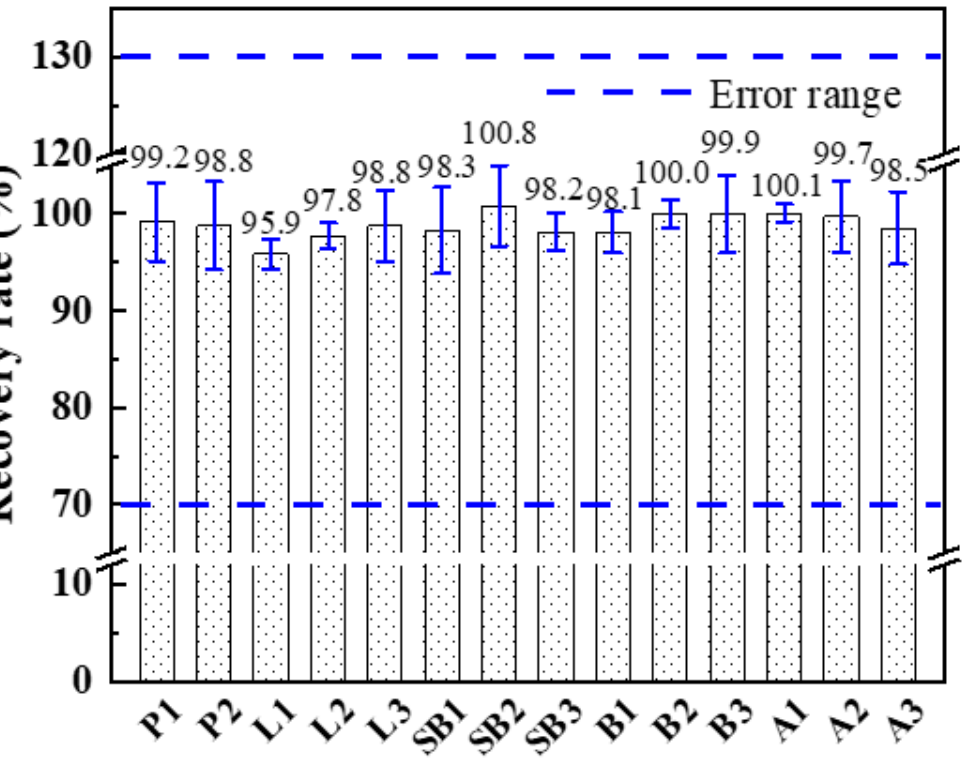
Figure 5. Hg recovery rate in coal samples by the TPD